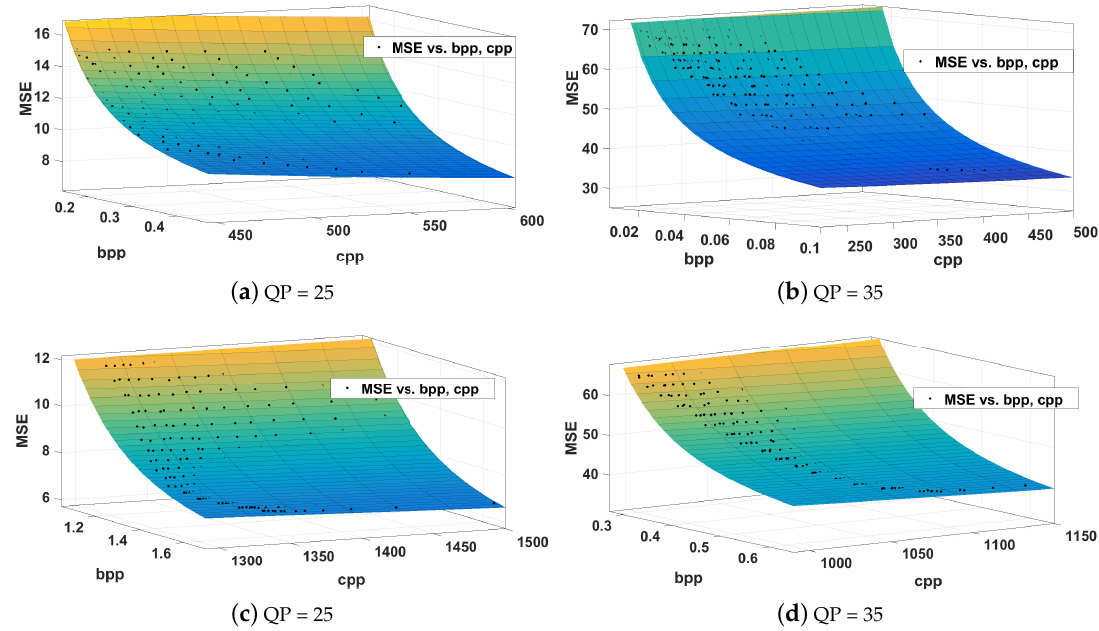
Figure 1. The decoding-complexity (cpp), rate (bpp) and distortion (MSE) behavior of inter-predicted ( top row ) and intra-predicted ( bottom row )